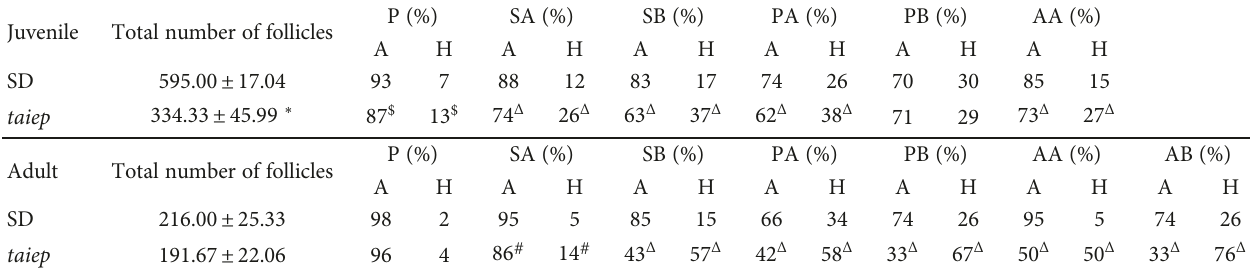
Table 2: Follicle population in the ovaries from the juvenile and adult taiep and Sprague – Dawley rats.